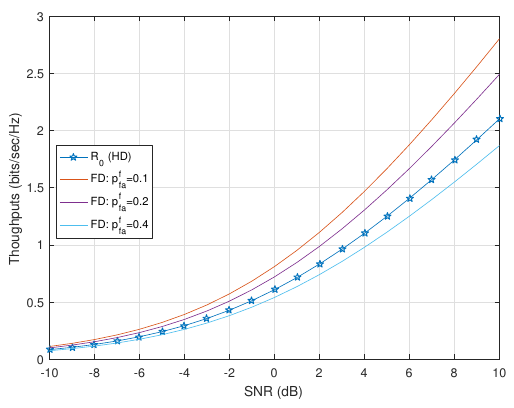
throughput increases rela tively to HD mode. Increasing